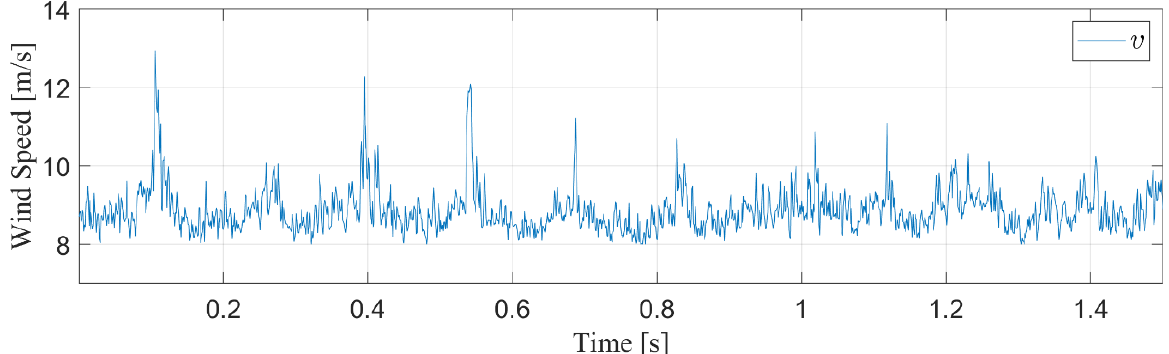
Figure 4. Turbulent wind speed profile for controller comparison.